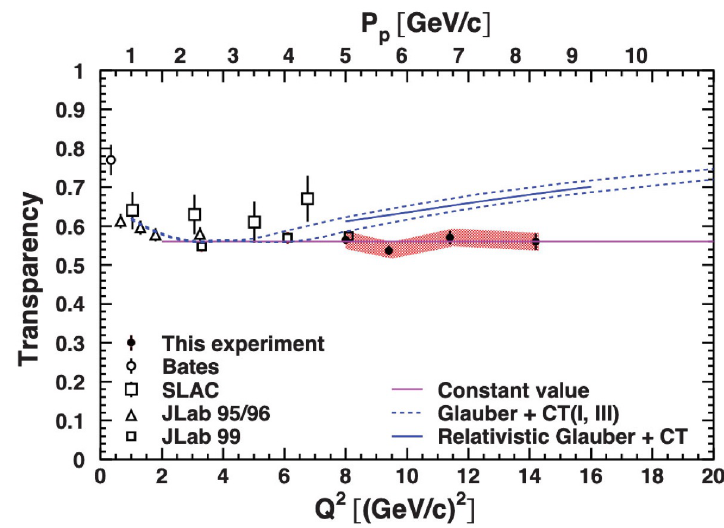
Figure 1. The momentum transfer squared, Q 2 , dependence along with the incident proton momen- tum, P p , dependence of the transparency ratio for 12 C measured recently by Bhetuwal et al. [12] and by the previous Jefferson Laboratory (JLab) experiments [8–11]. See text for details. Taken